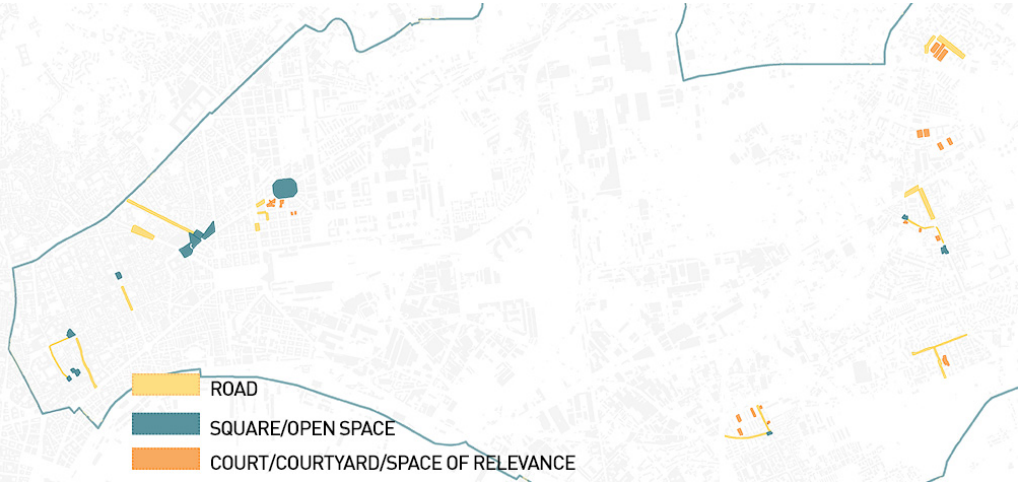
Figure 5. Identification and classification of sample areas.